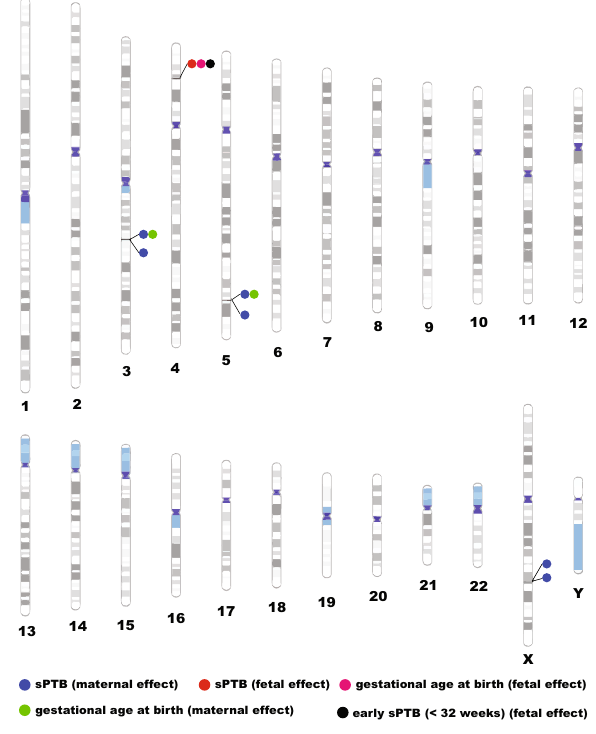
Fig. 3 Results of the genome-wide association studies. Only those loci which were associated with sPTB at minimally suggestive signi fi cance ( P < 1 × 10 − 6 ) in discovery stage and either got replicated or functionally validated are shown in this fi gure. Blue circles are showing maternal genetic associations with sPTB while a red circle is showing fetal genetic association with sPTB. The pink circle is showing fetal genetic variant which was also reported to be associated with gestational age at birth while green circles are showing maternal genetic variants which were also reported to be associated with gestational age at birth. The black circle is showing the association of the maternal genetic variant with early sPTB (less than 32